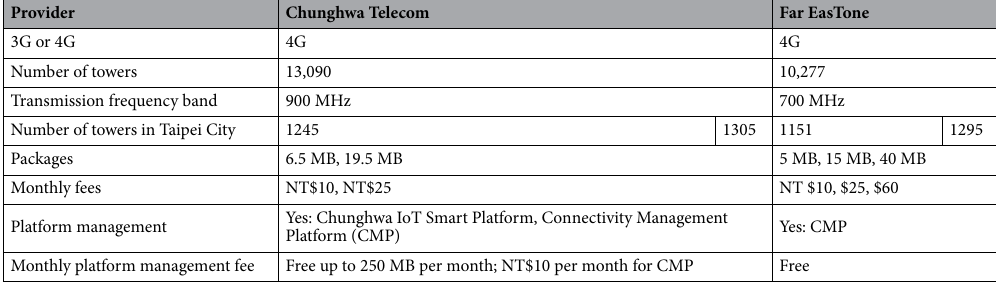
Table 3. Comparisons between two NB-IoT providers in